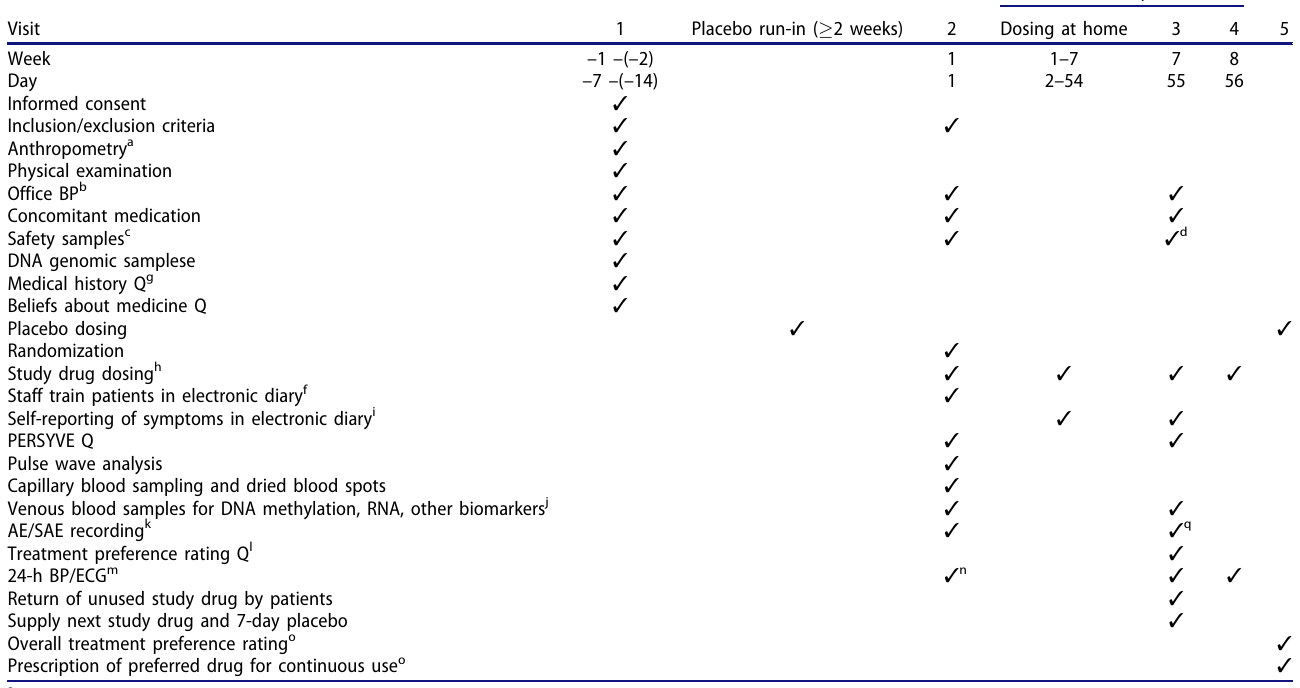
Table 2. Sequence of events. Visit Placebo run-in ( (cid:2) 2